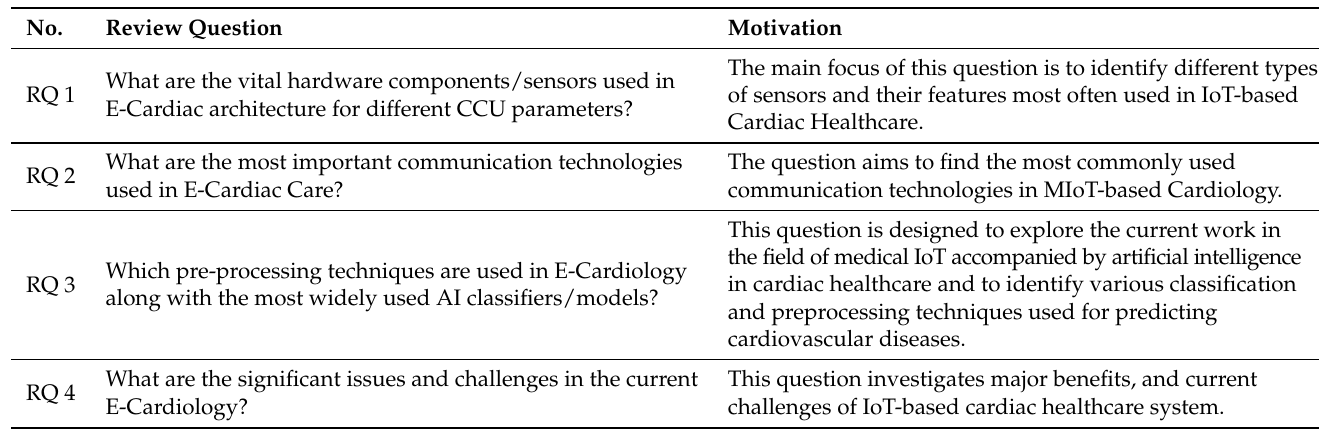
Table 2. Review questions and their motivation.